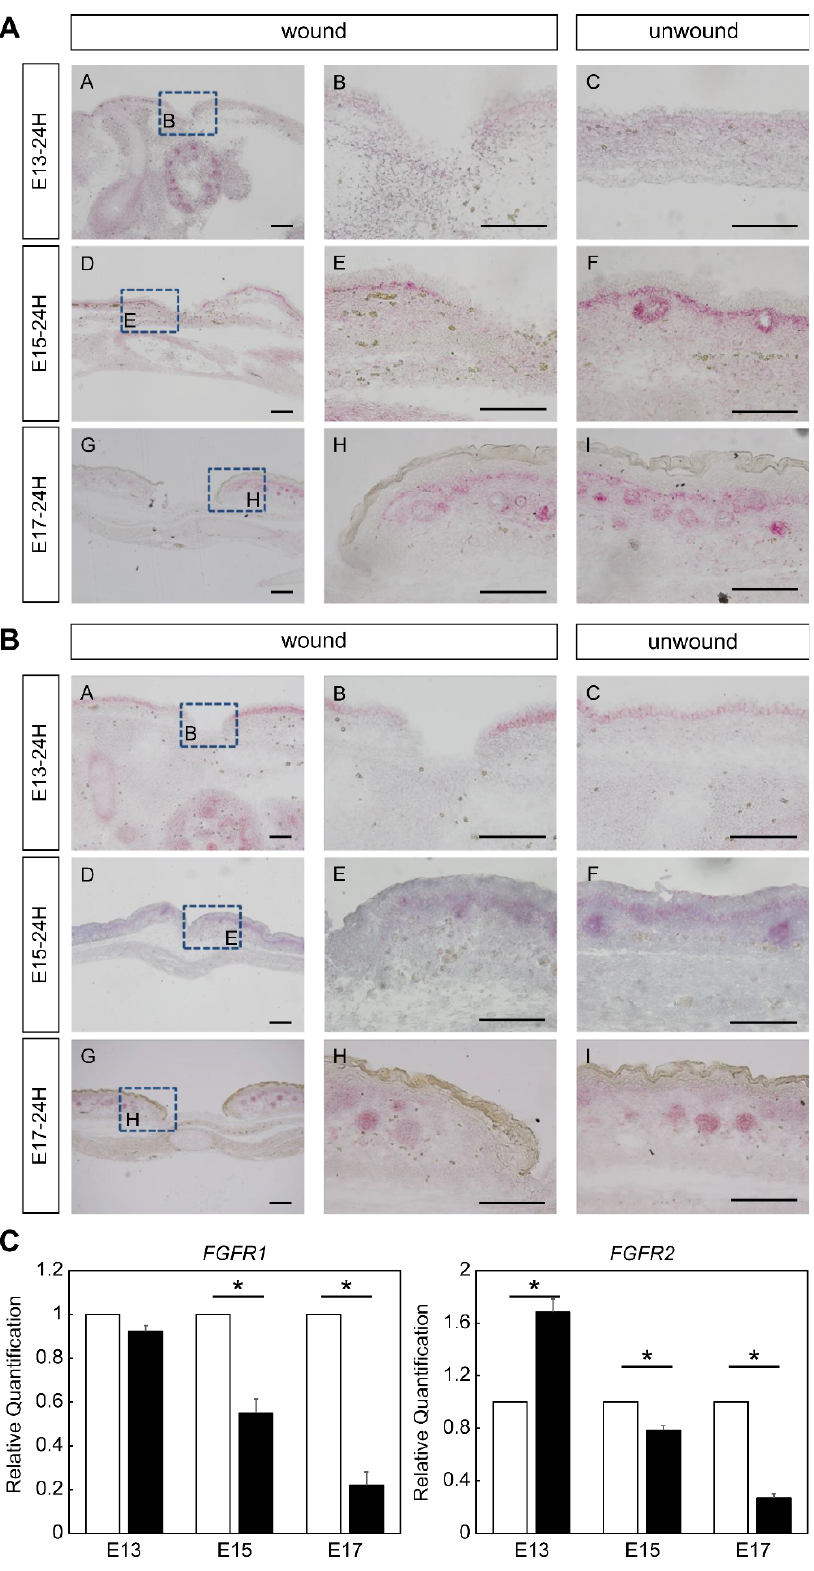
Figure 1. Expression of FGFRs during the wound healing process in mouse fetuses. FGFR1,2 positivity is indicated by red color. ( A ) in situ hybridization of FGFR1. ( B ) in situ hybridization of FGFR2. Bar = 100 µm. ( C ) Real-time polymerase chain reaction analysis of gene expression of Fgfr1 and Fgfr2 . *, p < 0.05. FGFR, fibroblast growth factor receptor; E13, embryonic day 13.